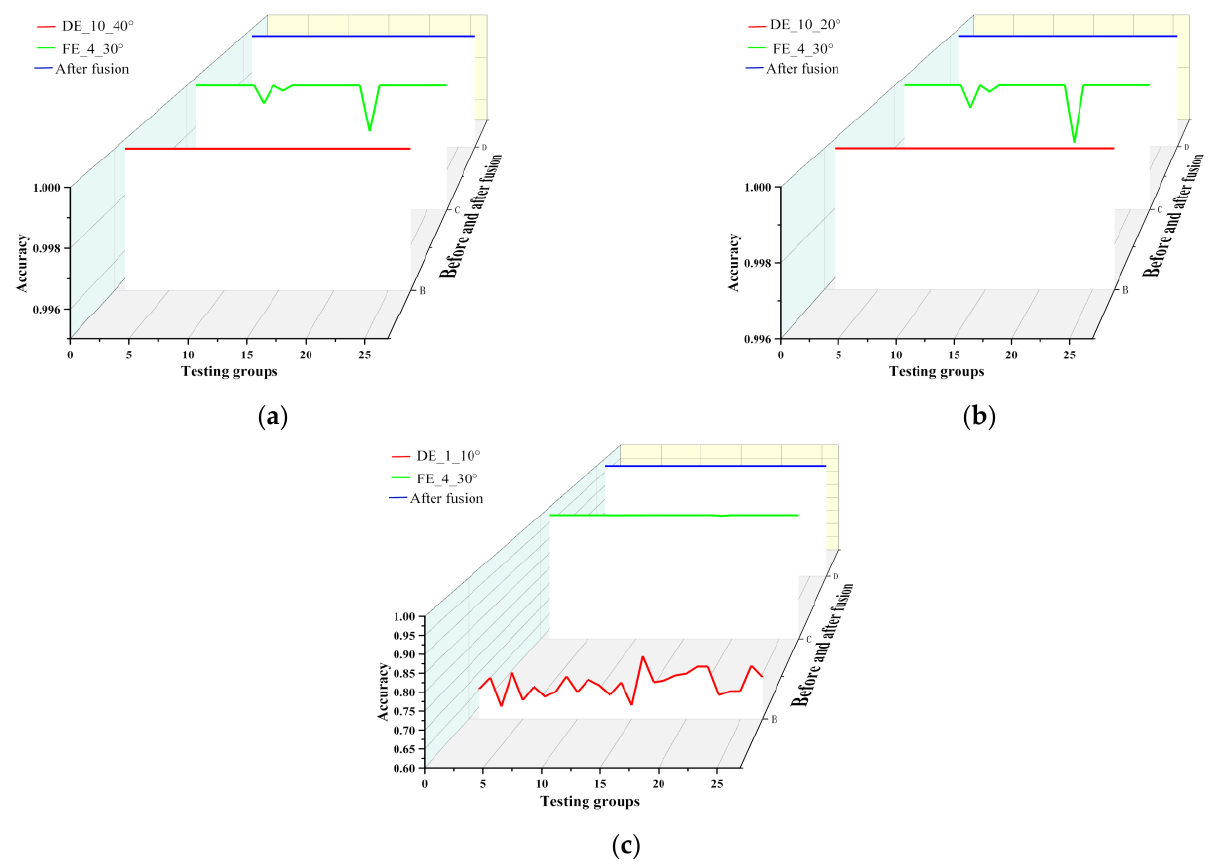
Figure 7. Diagnostic accuracy of bearings before and after fusion. ( a ) DE_10_40° and FE_4_30° fusion. ( b ) DE_10_20° and FE_4_30° fusion. ( c ) DE_1_10° and FE_4_30° fusion.